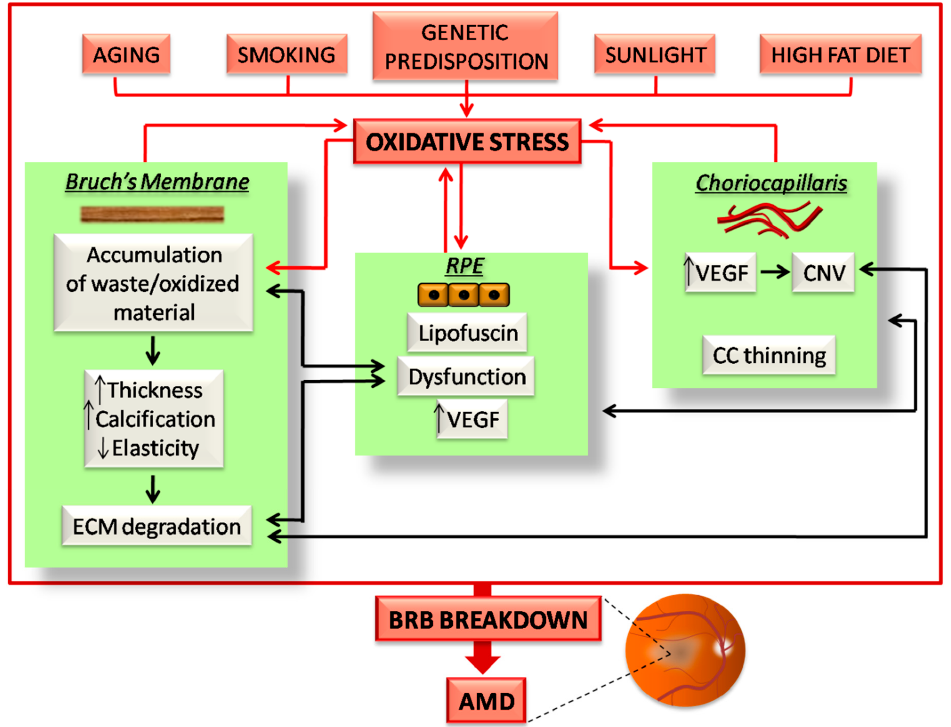
Figure 2. Schematic illustration of the events occurring in the outer BRB due to oxidative stress in age-related macular degeneration (AMD). All the risk factors for AMD induce oxidative stress burden, which affects the three components of the outer BRB. The effects of oxidative stress on the CC/BM/RPE complex culminates in a vicious cycle, which in turn induces further oxidative stress (red arrows). In addition, the induced damaging events of each BRB component inexo ‐ rably affects the function and structure of the others (black arrows). All of these events highlight the finely balanced na ‐ ture of the outer BRB, in which any alterations trigger a series of sequential events, which ultimately induce BRB break ‐ down and AMD. A detailed description about how oxidative stress affects the outer BRB in AMD is reported in the fol ‐ lowing paragraphs.